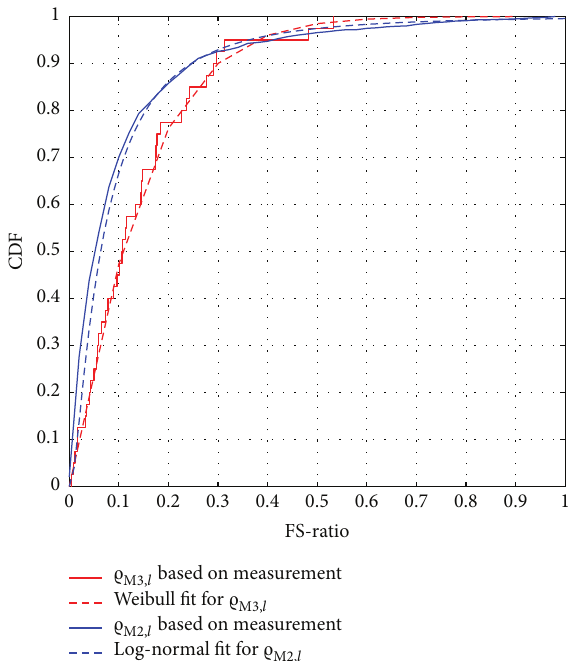
Figure 10: CDF of estimated FS-ratios 󰜚 M 2,𝑙 and 󰜚 M 3,𝑙 for Scenario-1. The 𝑝 values based on the Kolmogorov-Smirnov (KS) test [33] are 0.47 and 0.76 for types M2 and M3, respectively.